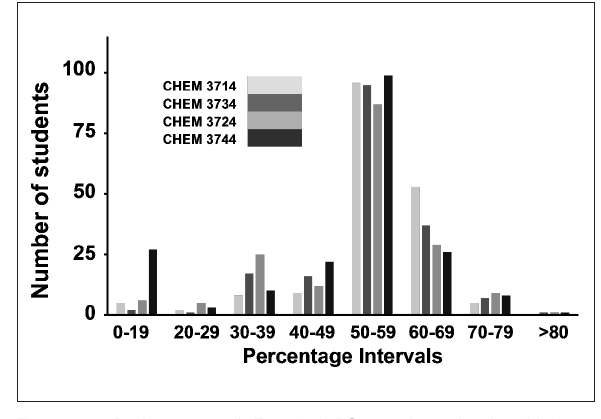
Figure 4: Performance of Extended BSc students in the second-year Chemistry modules CHEM2614, CHEM2632, CHEM2642 and CHEM2624 over the period 2006 to 2015.